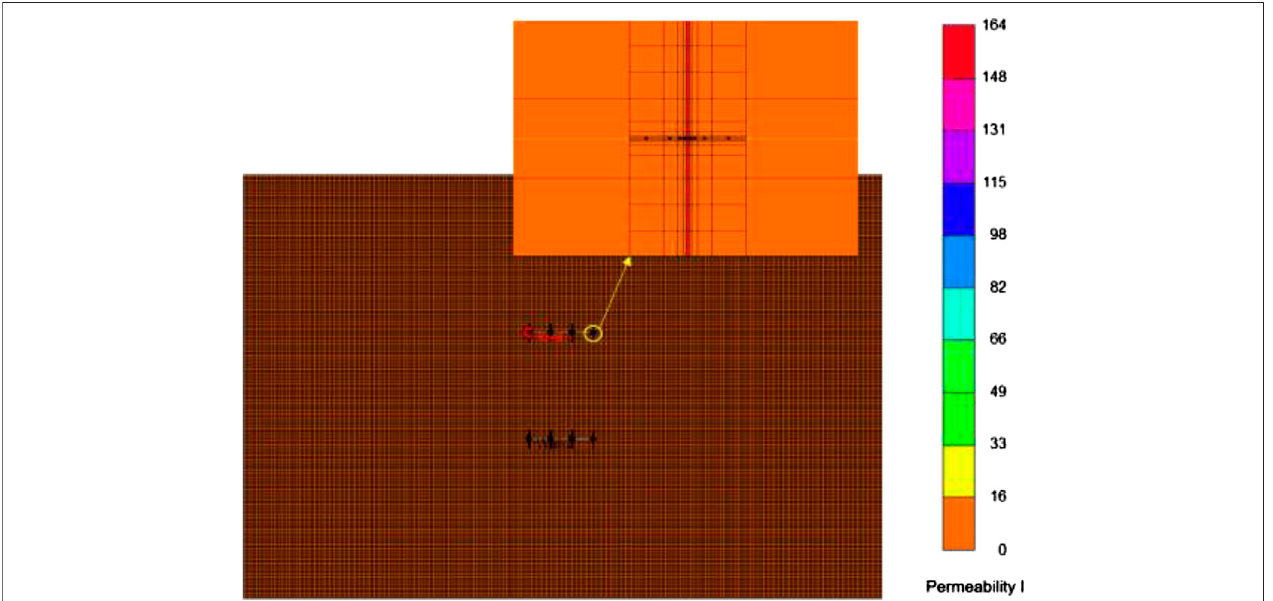
FIGURE 4 | Top view of commercial reservoir simulator simulator for the multi-well pad with multiple fractures.